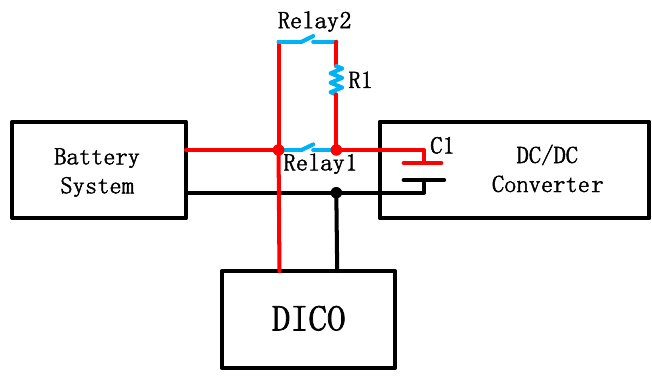
Figure 6. Electrical connection of battery system, DICO, and DC/DC converter.